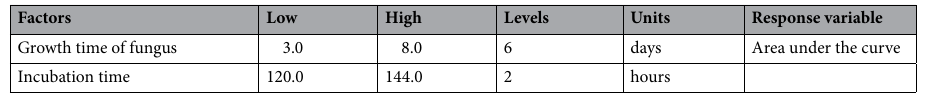
Factors Low High Levels Units Growth time of fungus Incubation Table 2. Attributes of factorial design multilevel CS samples of the fungus anamorphous Bjerkandera sp. R1.